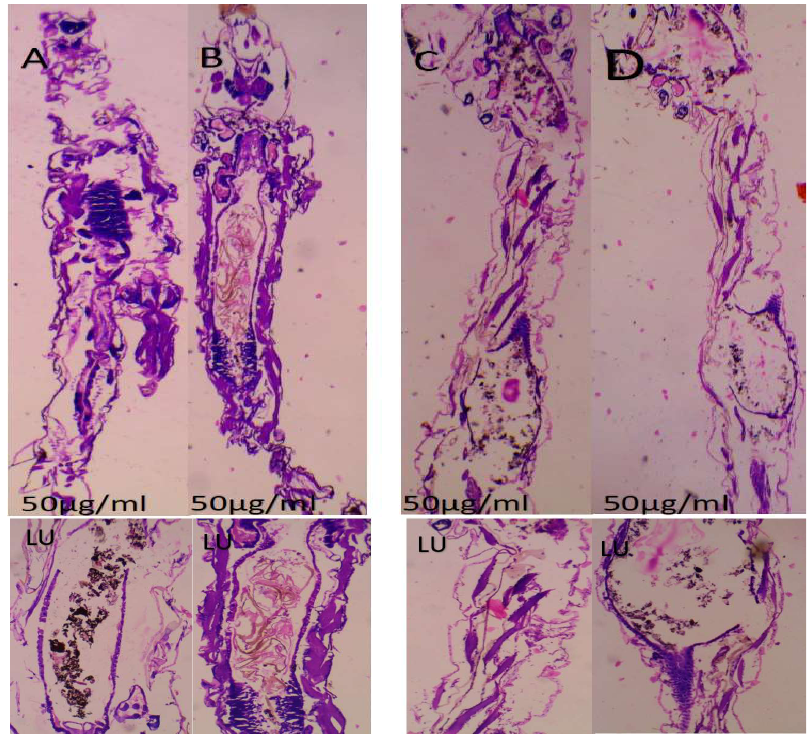
Figure 10. ( A , B ) Longitudinal section and midgut lumen of Anopheles stephensi larva exposed to 50 µ g/mL concentration of Pantoea stewartii - ( A ) and Priestia aryabhattai -mediated ( B ) silver nanoparticles; ( C , D ) longitudinal section and midgut lumen of Culex quinquefasciatus larva exposed to 50 µ g/mL